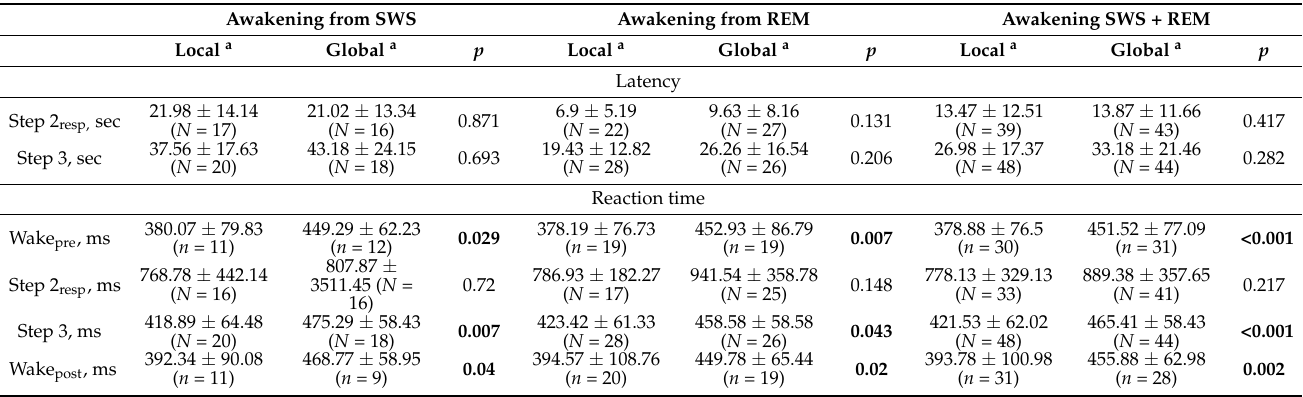
Table 2. Between sessions comparison of latency of MR recovery and reaction time on local or global irregularities in a waking state and during